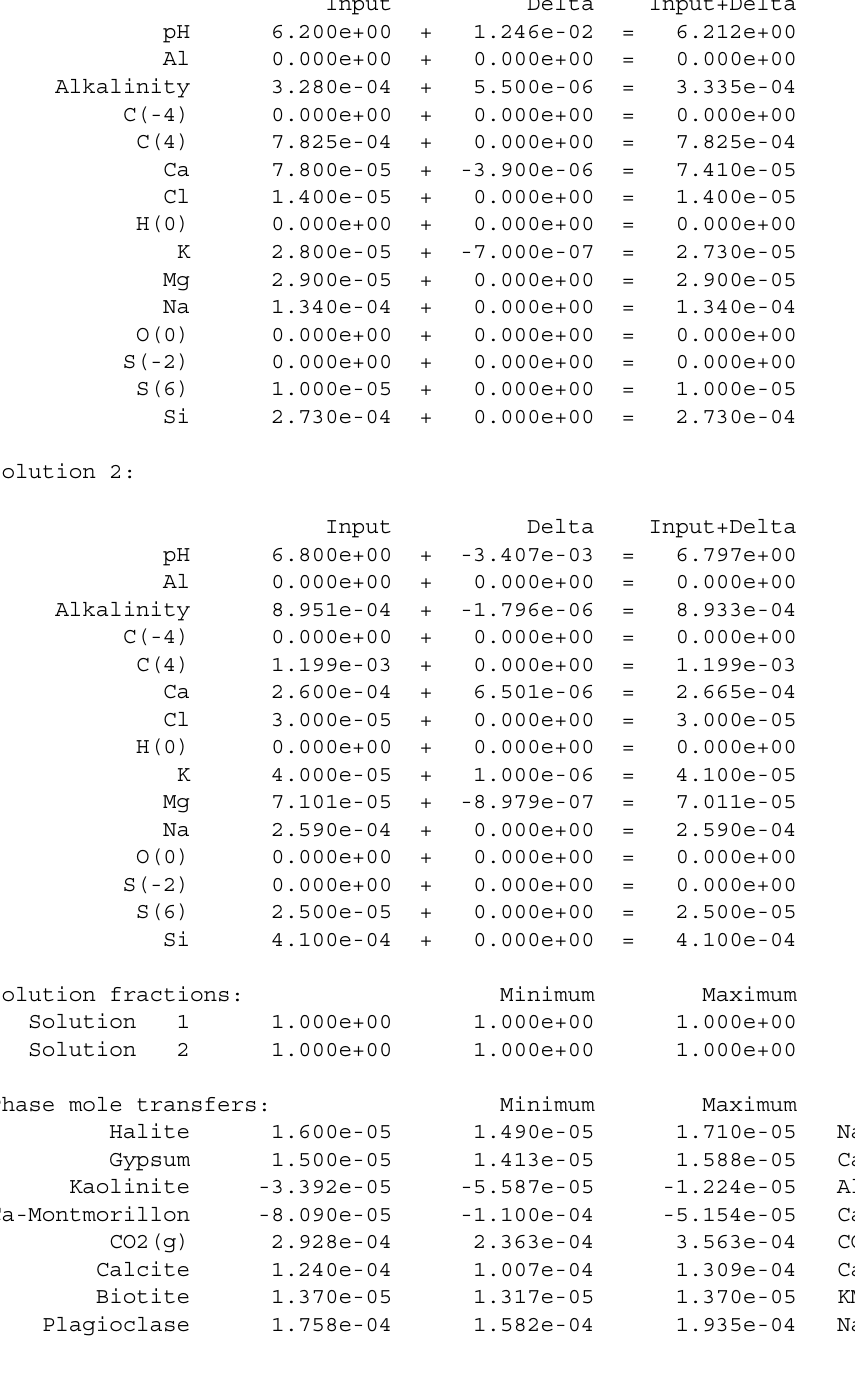
Table 48. Selected output for example